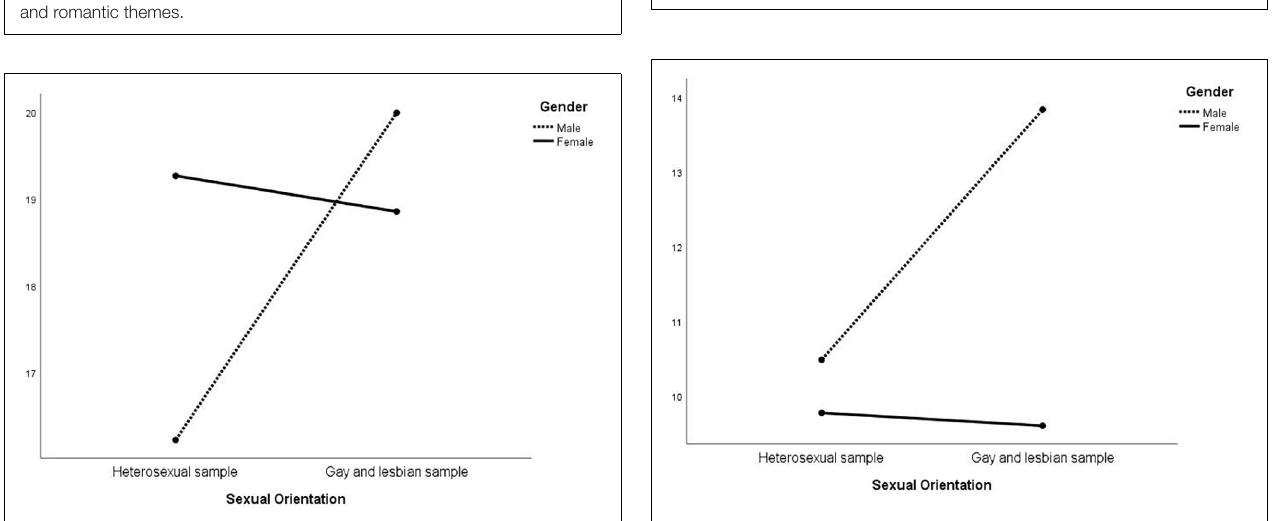
FIGURE 3 | Interaction of gender × sexual orientation on EIQ F3-dominance/ submission.